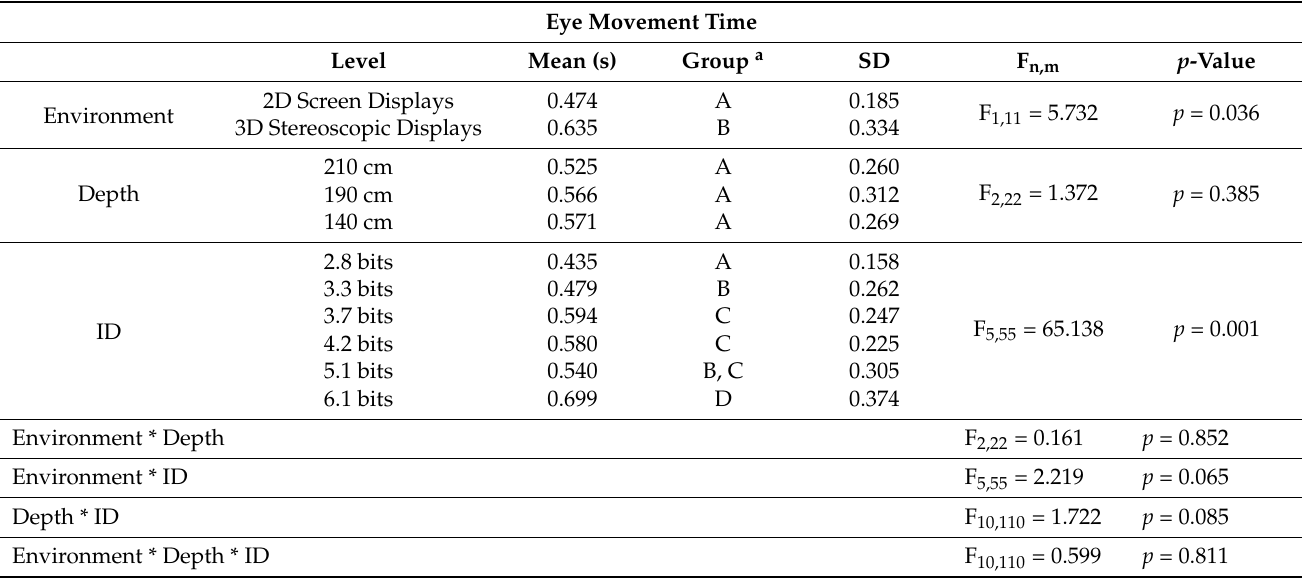
Table 3. Means, SDs, ANOVA, and Tukey HSD test results of eye movement time.